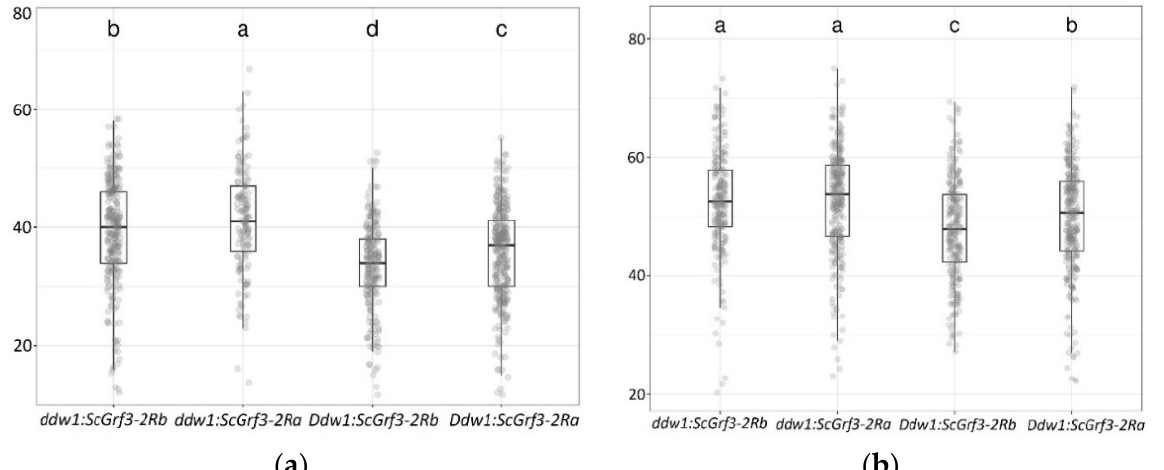
Figure 4. Thousand-grain weight (grams) in recombinant triticale lines with different combinations of Ddw1 and ScGrf3-2R alleles in 2018 ( a ) and 2019 ( b ). Letters denote significantly different groups at a significance level of 0.05 according to Tukey’s test. The rectangles show the interval between the 1st and 3rd quartiles, the vertical lines show the maximum and minimum values, the horizontal line inside the rectangle indicates the median, dots show the individual values of individual plants.